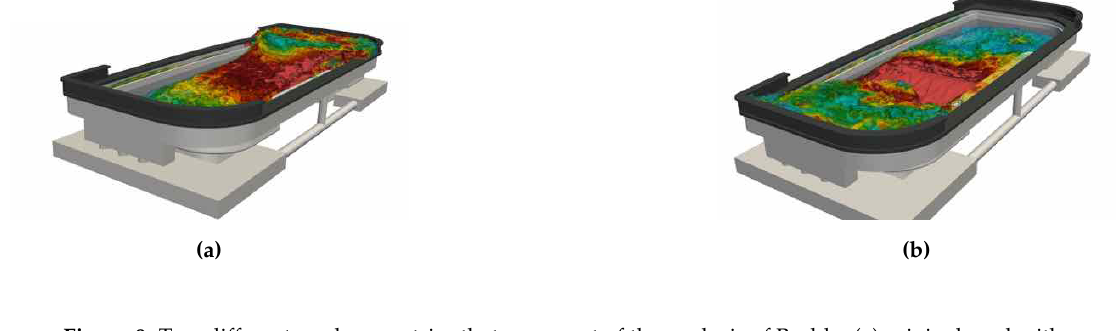
Figure 9. Two different pool geometries that were part of the analysis of Budde: ( a ) original pool with large sloshing amplitudes; ( b ) optimized pool with an irregular bottom elevation in the form of a bump with significantly lower sloshing amplitudes. Each simulation took only two hours on a single